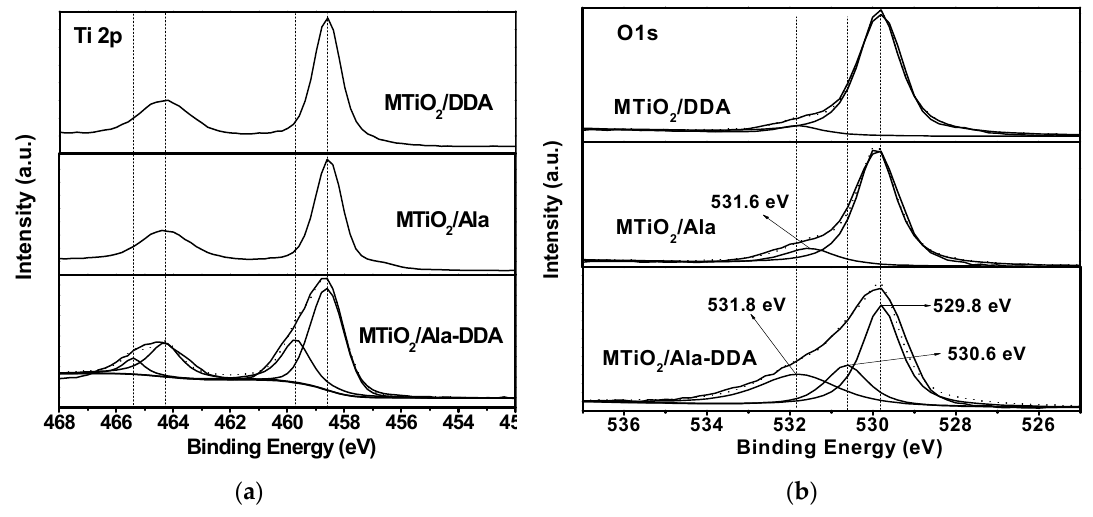
Figure 7. XPS ( a ) Ti 2p spectra and ( b ) O 1s spectra of MTiO 2 /Ala-DDA, MTiO 2 /DDA, and MTiO 2 /Ala.